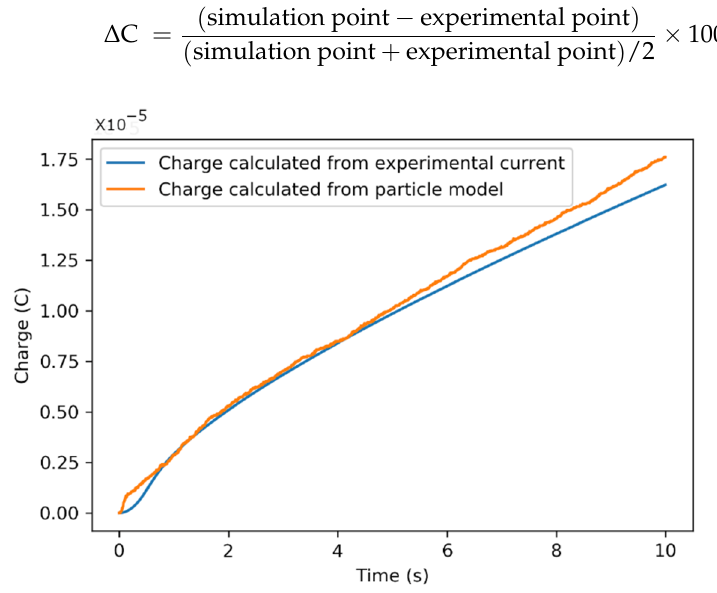
Figure 7. Experimental vs. actual numerical charge estimated data for 0.75 V potentiostatic charge.